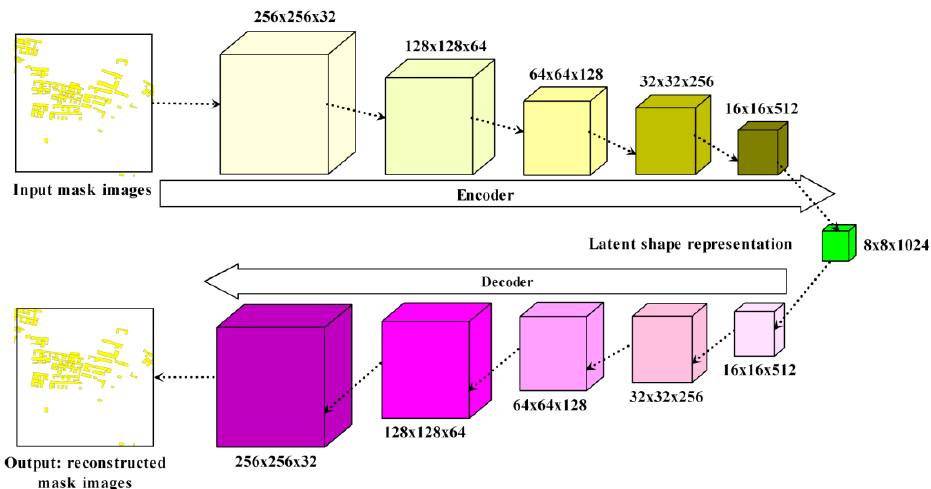
Figure 4. The autoencoder of shape representation model for buildings.